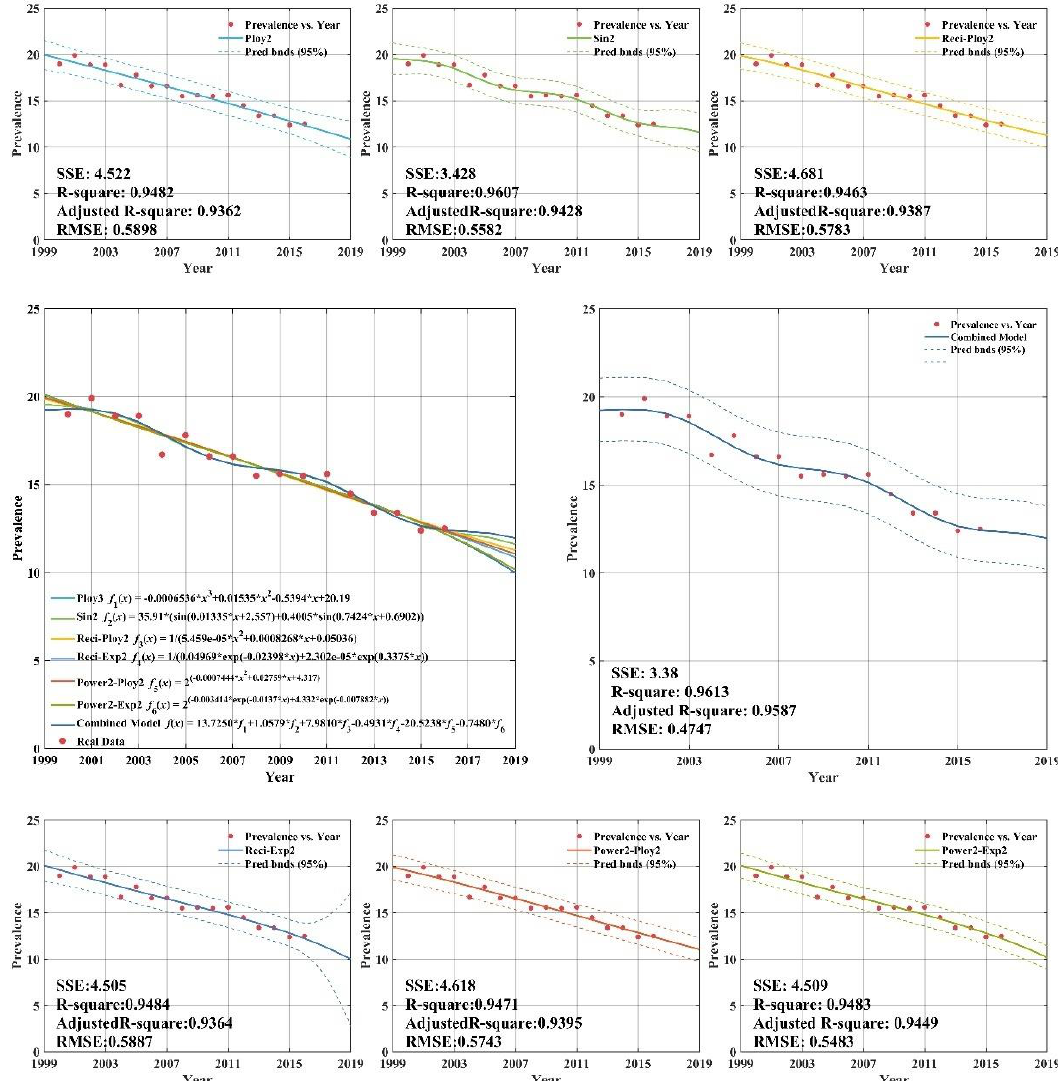
Figure A1. Fitting and forecasting curves for the high income group.